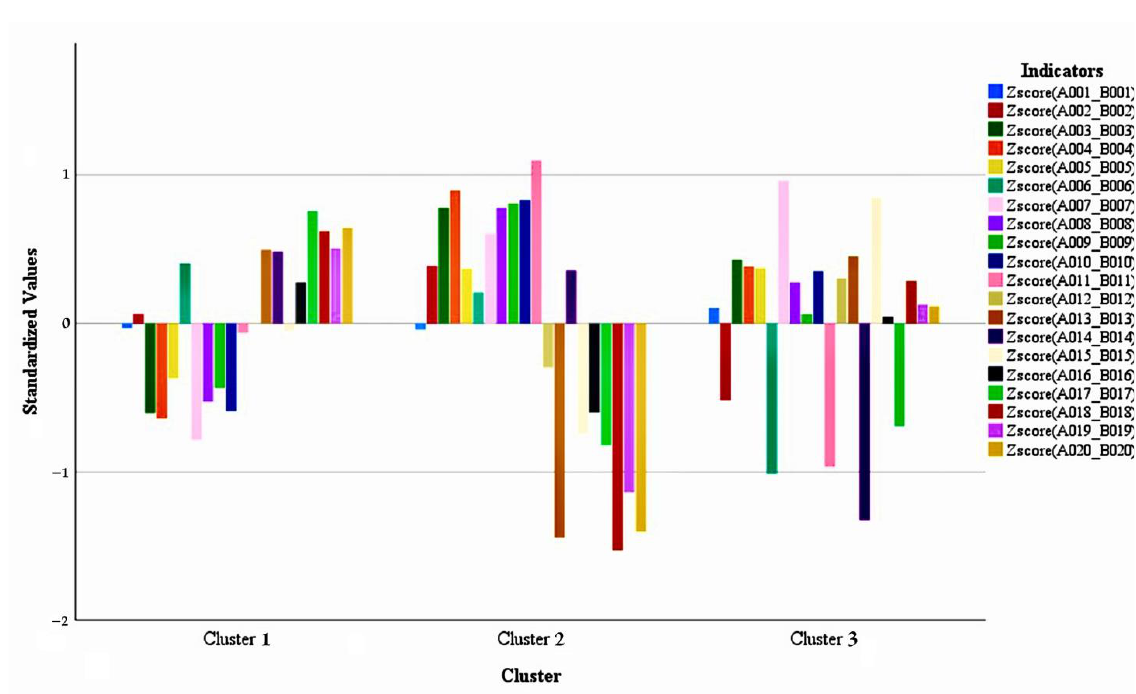
Figure 5. The balance/imbalance levels of indicators in each cluster.